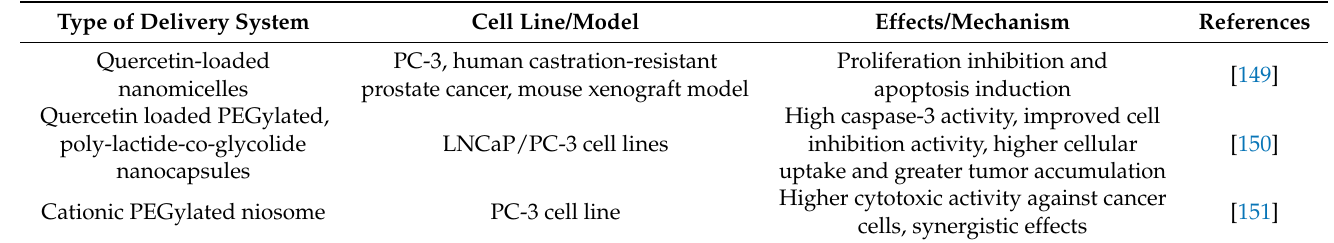
Table 3. Quercetin and its nanoscale